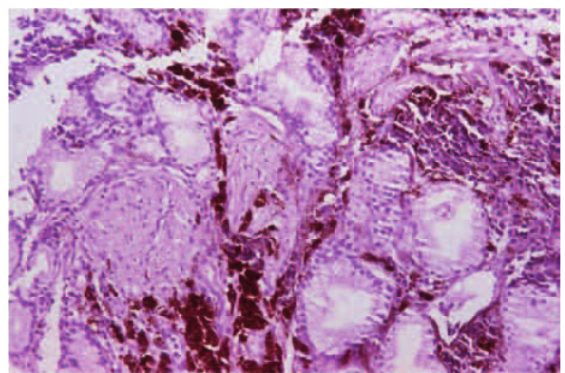
Figure 4. Metastatic lesions of the lung adenocarcinoma at the descendent